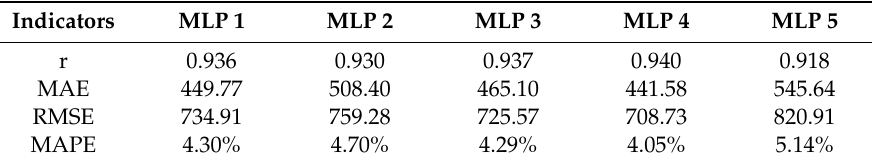
Table 8. Performance evaluation of proposed models.